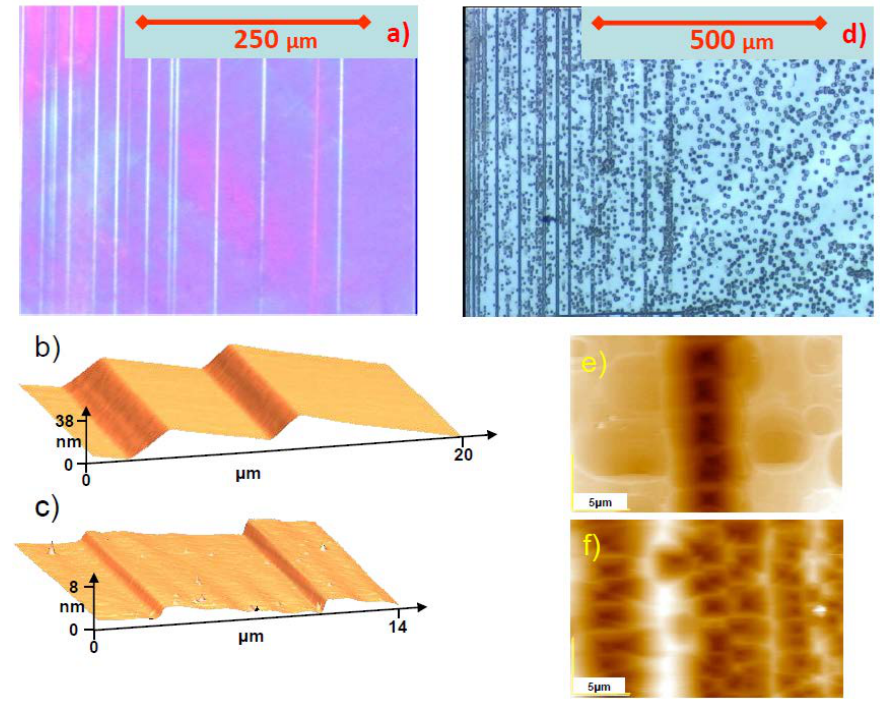
Figure 68. Optical inspection ( a ) and AFM topography ( b , c ) of mechanical deformed SrTiO 3 crystal (100) along [010] directions confirmed a discrete shift of the crystal blocks (on the whole width of the crystals) in the plastically deformed region. Relative shift of the blocks is about 8–40 nm ( b , c ) Using etch pits techniques it can be confirmed that a high concentration of edge dislocations and their bundle is present along the linear boundary between shifted blocks ( d ). Notice: because the density of etch pits outside of the region with plastic deformation is similar in comparison to the shifted blocks, it is possible that the dislocations array between the blocks are not only created via gliding of existing dislocations of the original crystal but a new population of dislocations could be nucleated under the influence of the external forces. AFM measurement of the topography of etched crystals shows linear arrangement of etch pits along the boundary between plastically deformed regions of the crystal ( e , f ).